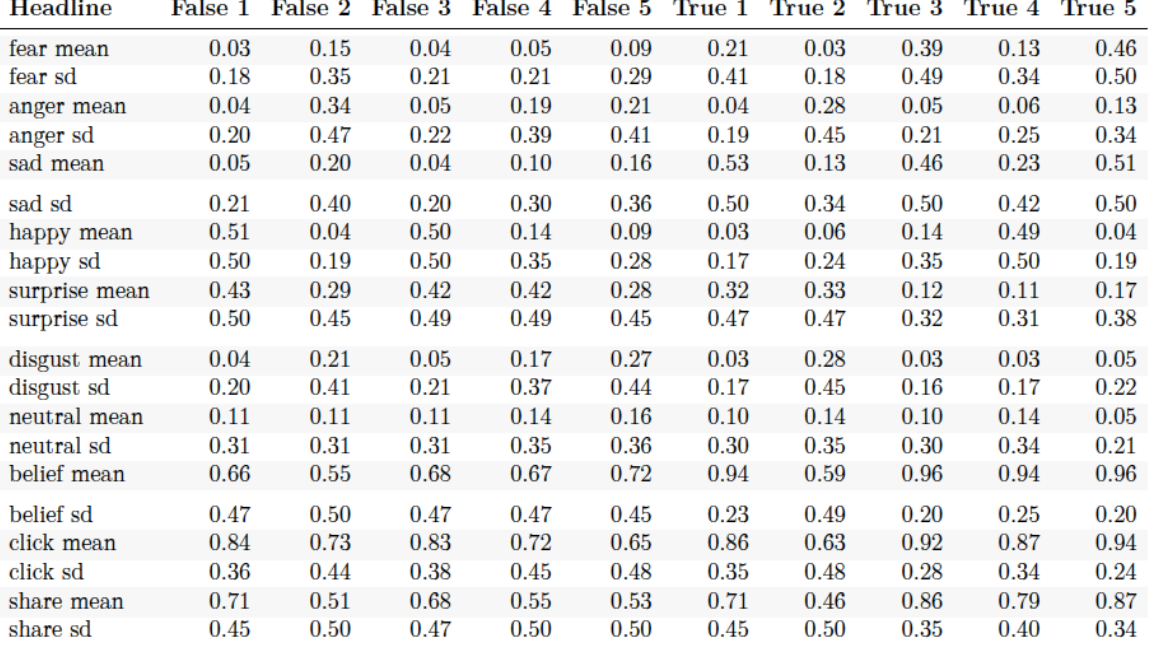
Table D1. Distribution of emotions for each stimulus.